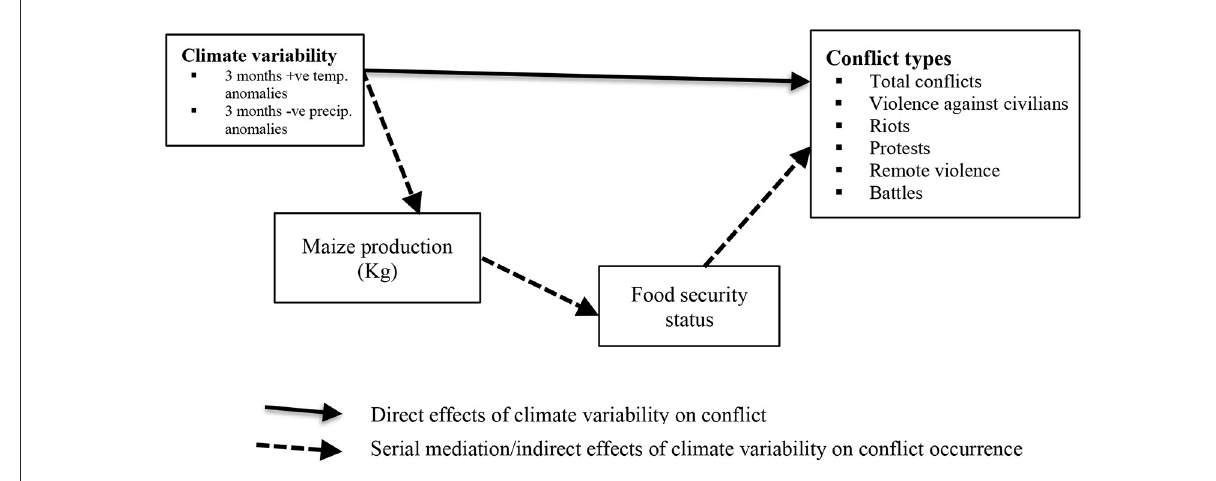
FIGURE1 Conceptual model indicating the pathways linking climate variability to